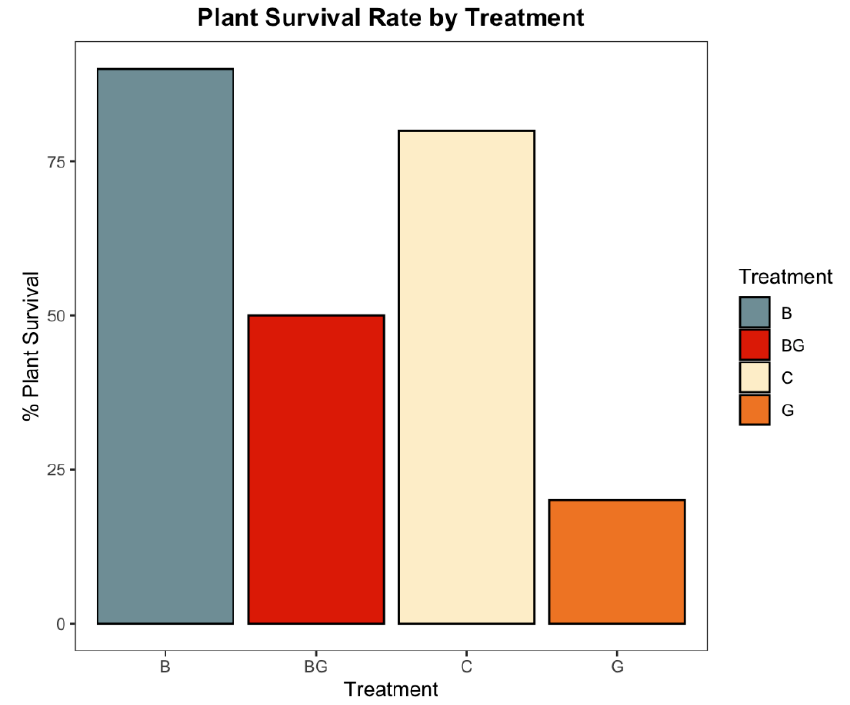
Figure 8. Final plant survival rate. Plants were analyzed for survival with respect to the treatment received.